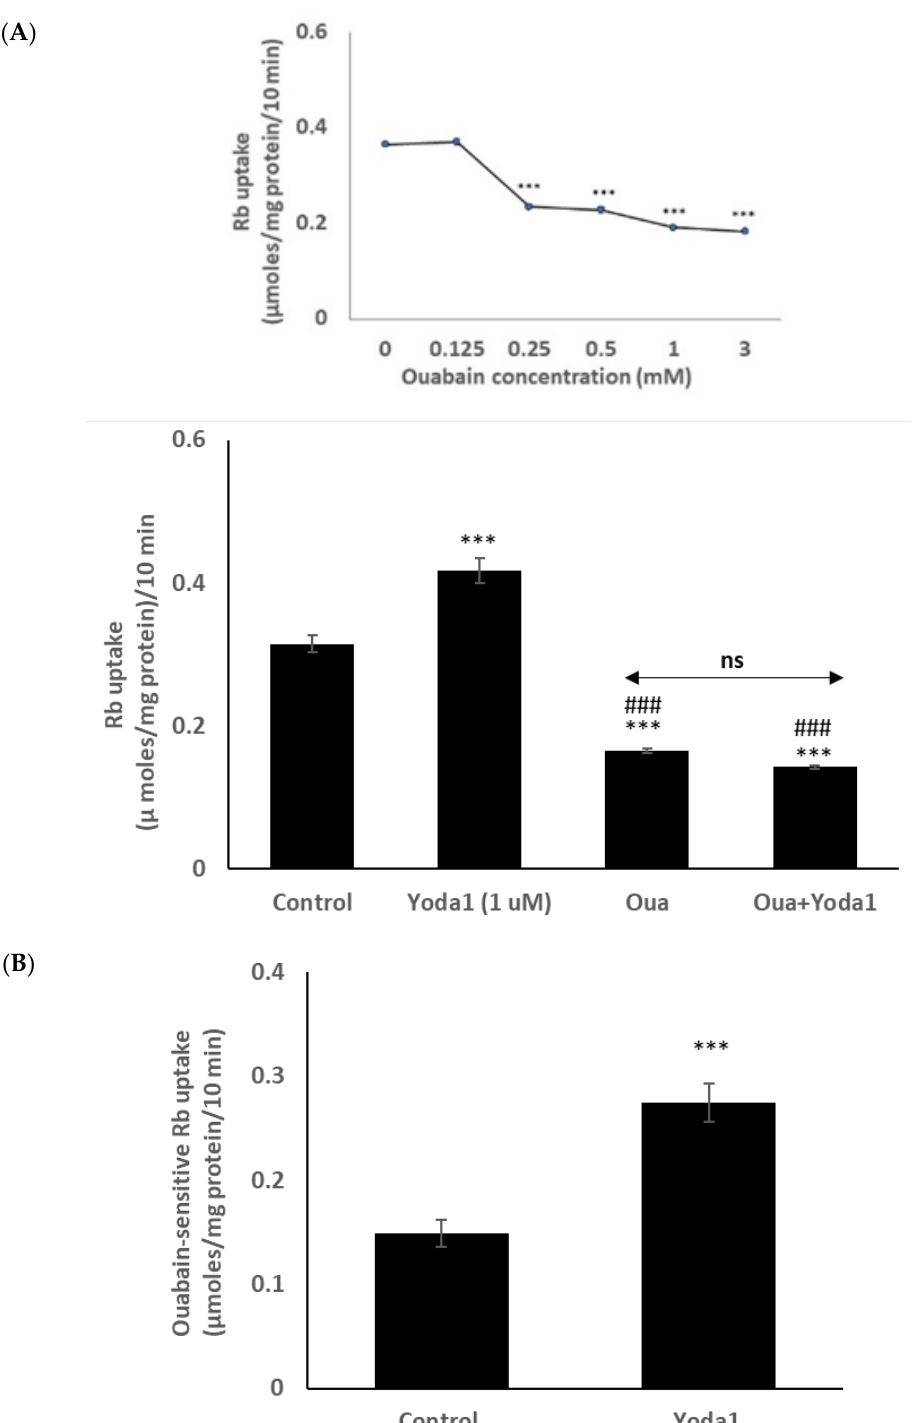
Figure 5. In the presence of the Na,K-ATPase inhibitor ouabain (1 mM), Yoda1 did not increase the Rb in cultured lens epithelium. ( Panel A ) shows Rb uptake in cells that were exposed to Yoda1 (1 µ M) in Rb-containing Krebs solution ± ouabain for 10 min. Added alone, ouabain reduced Rb uptake. The concentration-dependence of the ouabain effect on Rb uptake is shown in the upper left (inset). ( Panel B ) shows the ouabain-sensitive component of Rb uptake. The values are the mean ± SEM of results from 6 independent experiments. *** indicates a significant difference ( p < 0.001) from the control, and ### indicates a significant difference ( p < 0.001) from Yoda1 treatment, as determined by one- way ANOVA followed by Šídák’ s multiple comparison test. ns = not significant.